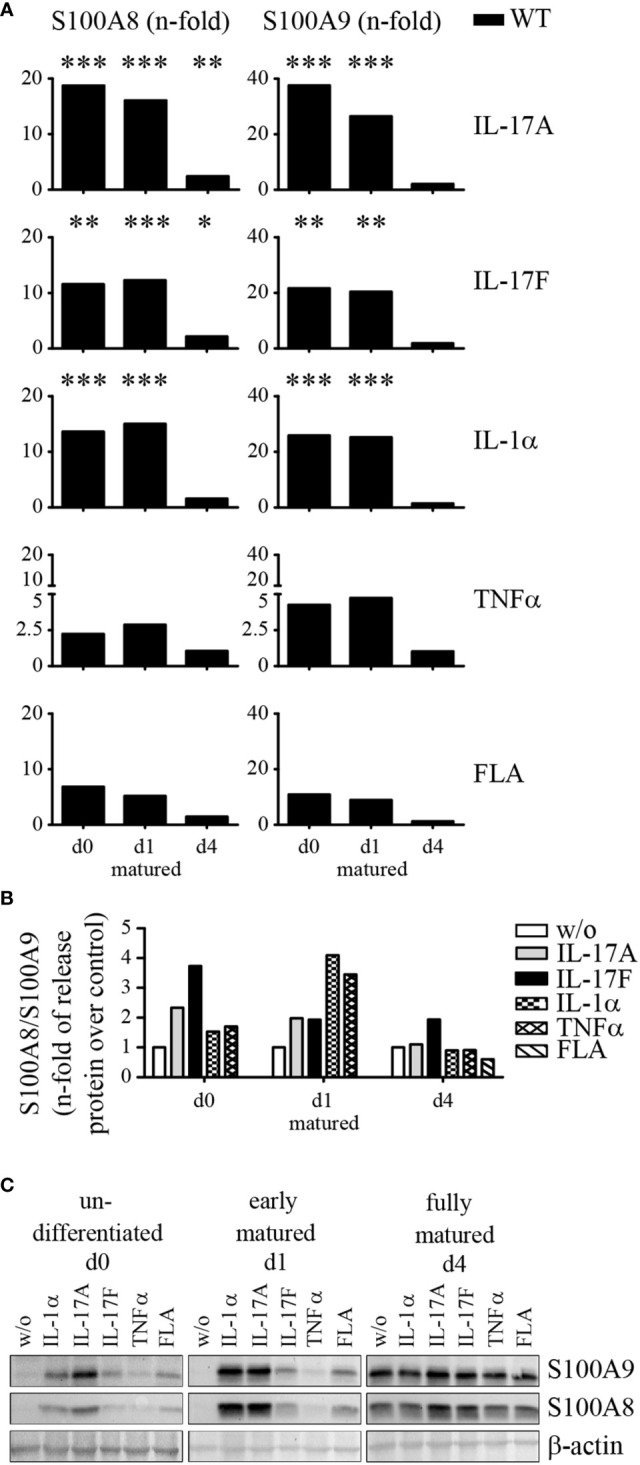
Stimulation of S100A8 and S100A9 protein expression in naïve primary keratinocytes. Primary keratinocytes were isolated from wildtype C57BL/6 mice, matured, and stimulated for 24 h ex vivo. (A) Messenger RNA (mRNA) expression of S100A8 and S100A9 were analyzed by quantitative real-time PCR. Columns represent means ± SEM of at least five independent experiments. Values were standardized to RPL housekeeping gene and represent the n-fold to their respective unstimulated WT keratinocytes at each maturation time point (w/o = 1). Asterisks indicate significant differences to unstimulated controls based on the original expression data (ANOVA *p < 0.05; **p < 0.01; ***p < 0.001). (B) Release of S100A8/S100A9 into culture supernatants by WT keratinocytes during maturation was analyzed after incubation with different stimuli via ELISA. Columns represent the means ± SEM of at least three independent experiments. Values represent the n-fold to unstimulated WT keratinocytes (w/o = 1). Student’s t-test revealed no significant differences. (C) Expression levels of S100A8 and S100A9 in primary WT keratinocytes were determined by Western blotting. β-actin served as loading control. One representative experiment out of two independent experiments is shown.